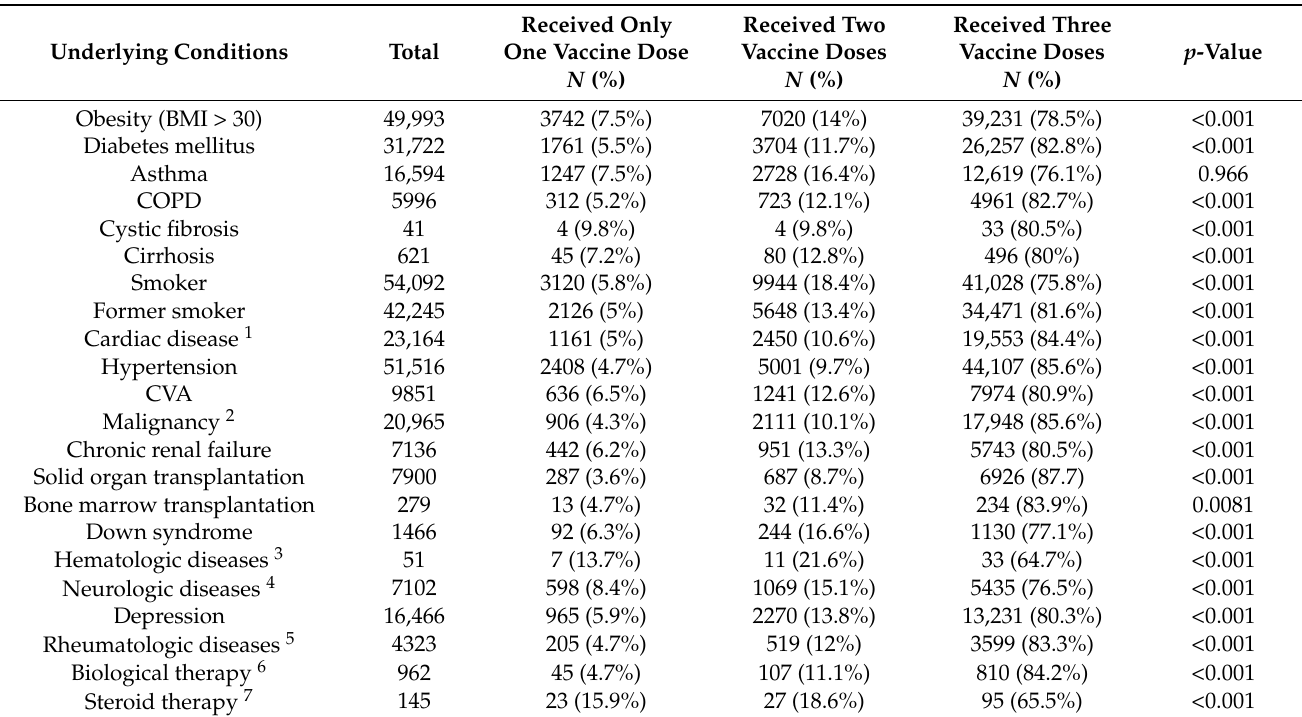
Table 4. Characteristics of study group with underlying medical conditions by the number of COVID-19 vaccine doses